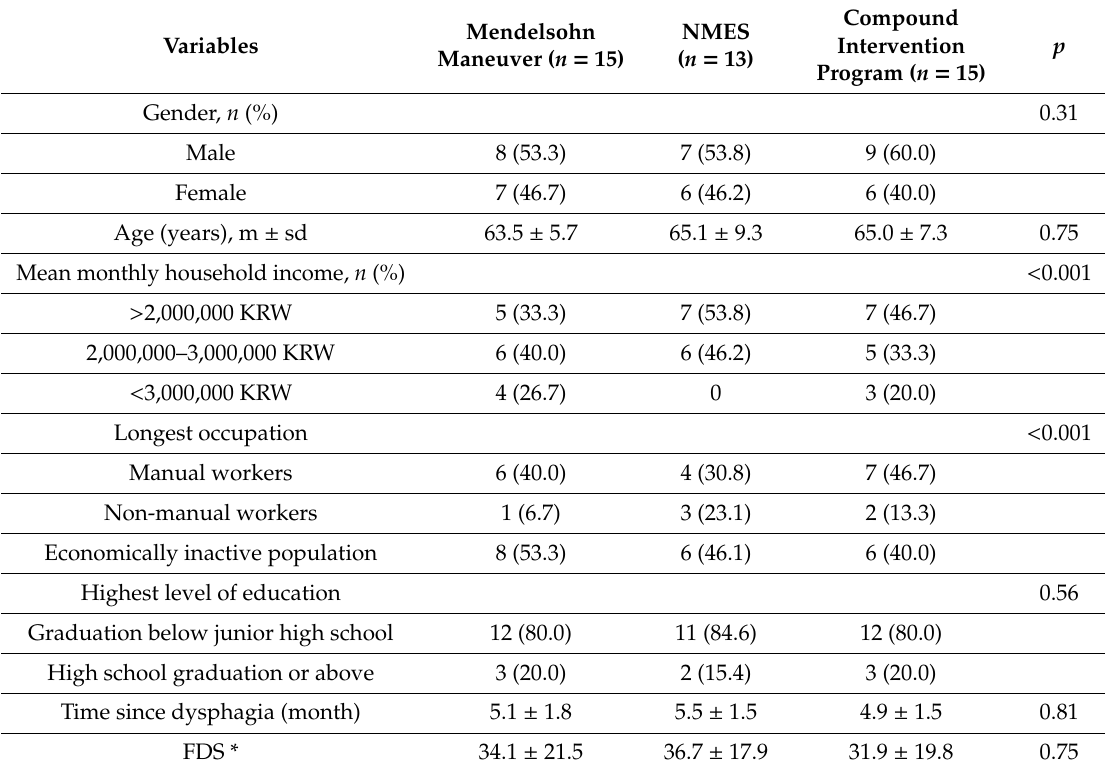
Table 1. Baseline characteristics of subjects, M ±